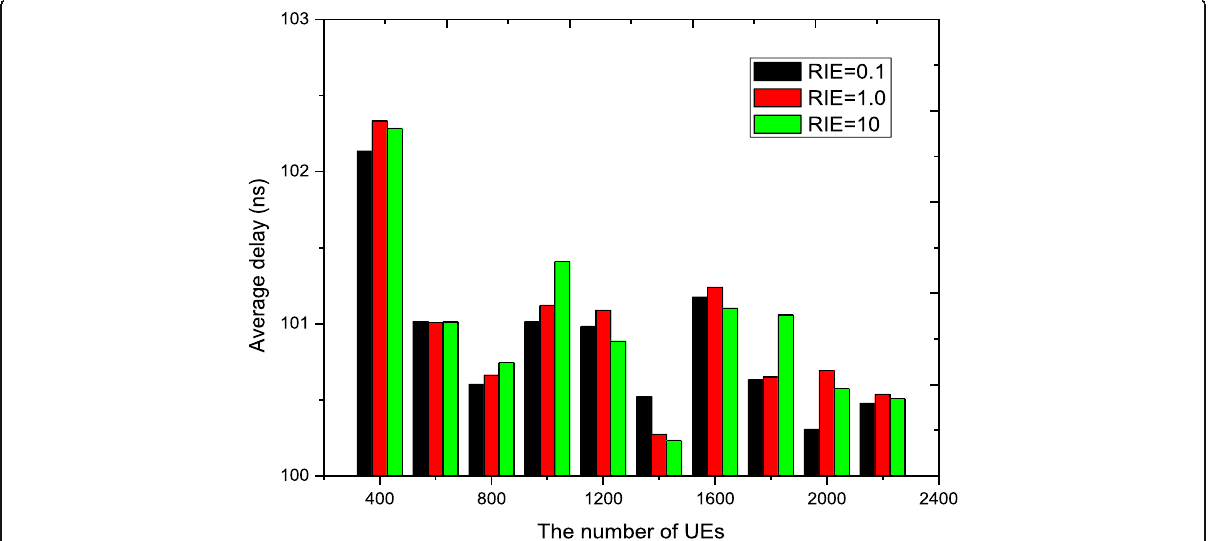
Fig. 14 Average delay for the DTO-MROD scheme under the different typical values for RIE threshold